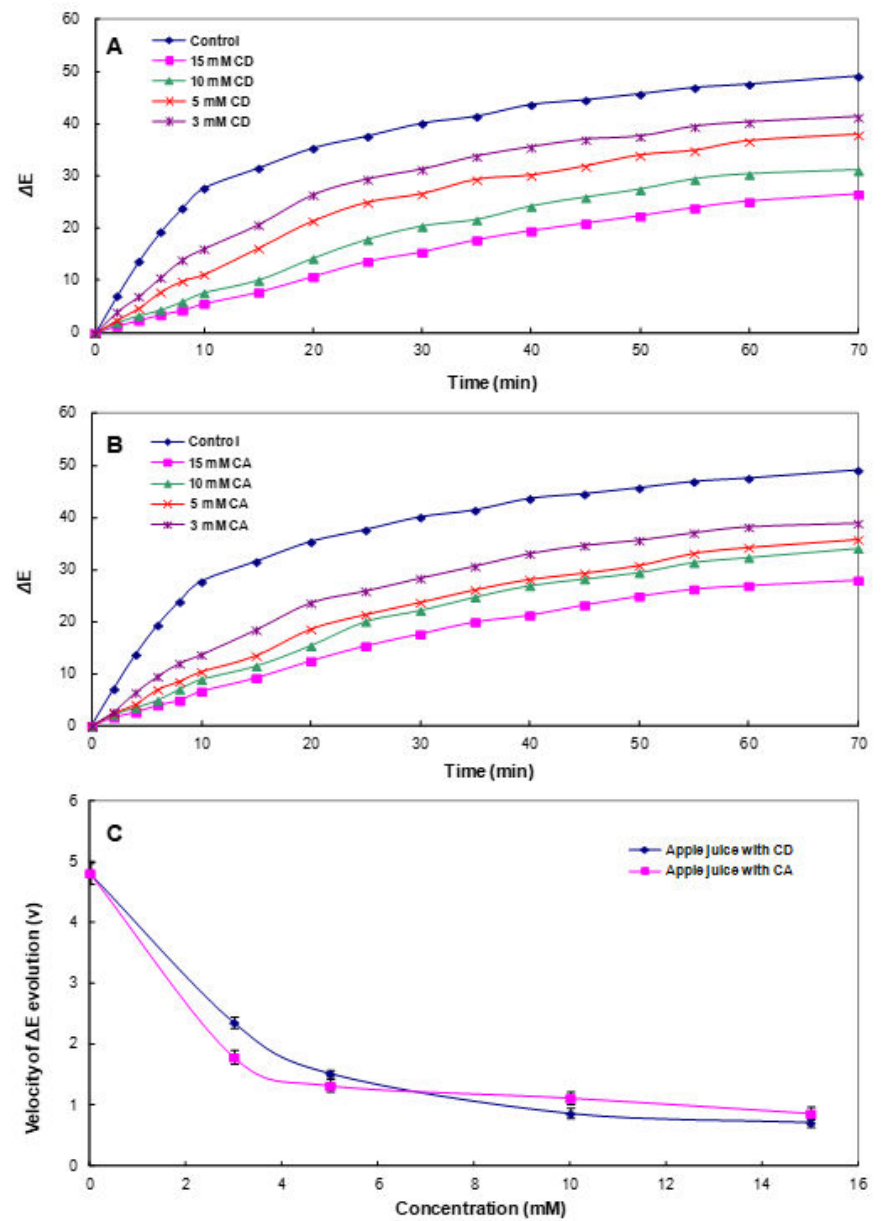
Figure 5. The evolution of total color difference ( ∆ E *) in apple juice in the absence and presence of ( A ) cyclodextrin (CD) and ( B ) cycloamylose (CA). ( C ) The velocity of ∆ E * evolution ( ν ). Each data point is the mean of three